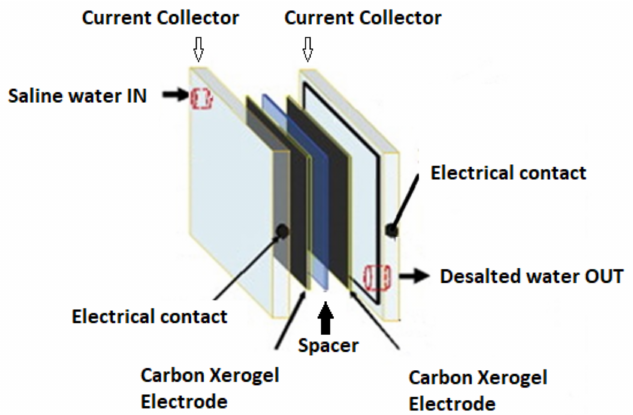
Figure 19. Schematic configuration of one CDI cell.